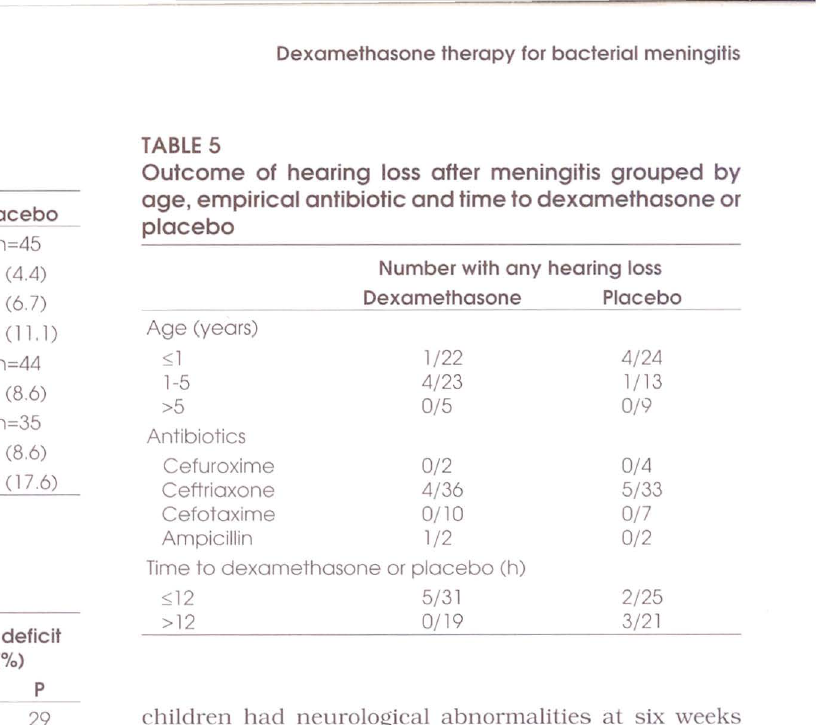
Outcome of meningitis by etiological